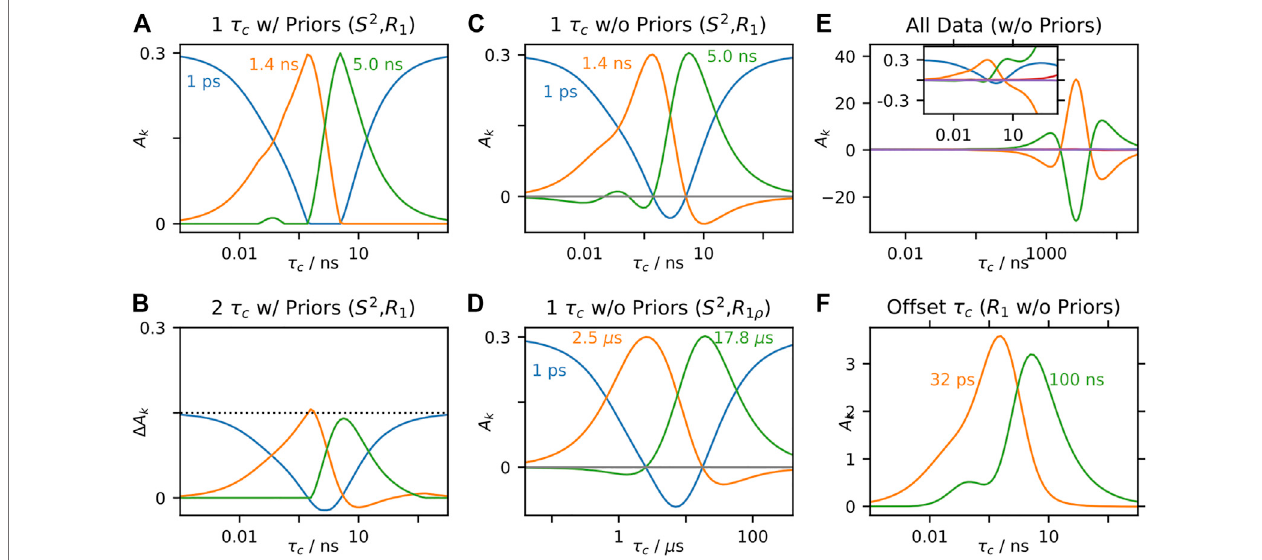
FIGURE 9 | IMPACT behavior in solids. In each plot, we test the behavior of the amplitudes, A k , using calculated solid-state NMR data ( S 2 , 15 N R 1 , 15 N R 1 ρ , with experimentalconditionstakenfromSmithetal.(2016)). (A) plotsthebehaviorof fi tting S 2 andthree R 1 rateconstantstothreecorrelationtimes(1 ps,1.4 ns,5 ns),where the input correlation function has a single correlation time ( ( 1 − S 2 ) (cid:2) 0.3), while restricting the A k to fall between 0 and 1. (B) shows fi ts under the same conditions, but includestwocorrelationtimes,withone fi xedat1 ns,andtheotherswept( x -axis).The y -axisplotsthechangeinthe A k duetothesweptcorrelationtime. (C) shows fi ts S 2 and R fi ts under the same conditions as (A) , without restricting the values of the A k . (D) also removes restrictions on the A k , but 1 ρ data, using correlation times of (1 ps, 2.5 μ s, and 17.8 μ s). (E) fi ts all data ( S 2 , R 1 , R 1 ρ ) simultaneously without restrictions on the A k , with correlation times of 1 ps, 1.4 ns, 5 ns, 2.5 μ s, and 17.8 μ s (F) fi ts R 1 data, but uses one very short correlation time (32 ps), and one very long correlation time (100